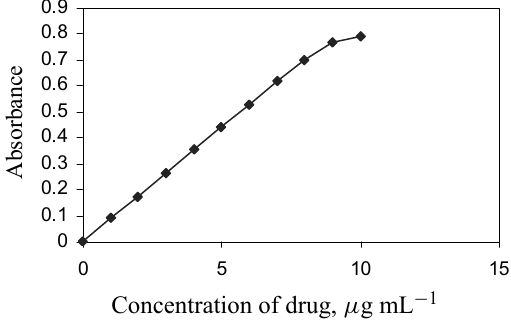
Fig. 4 – Beer’s law curve for method